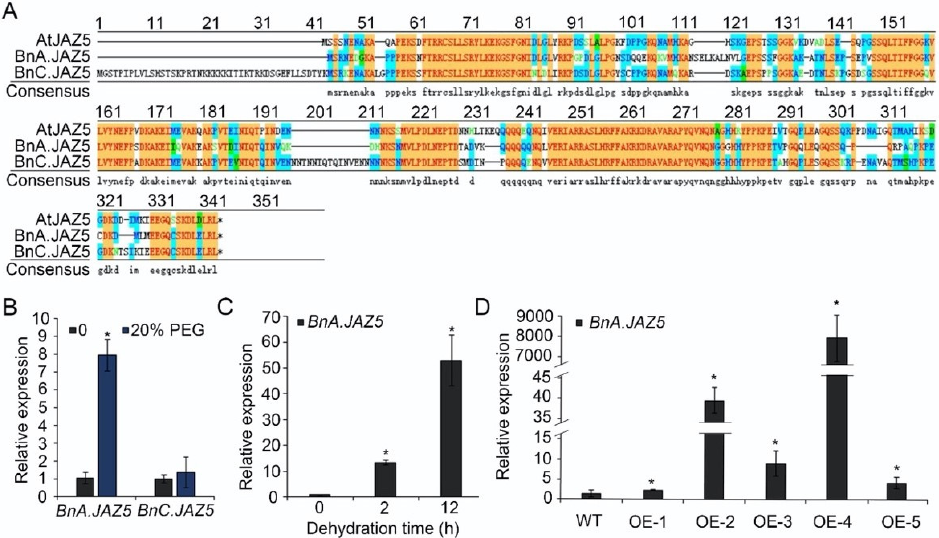
Figure 1. Homologous alignment of AtJAZ5 in rapeseed and expression levels of BnA.JAZ5 and BnC.JAZ5 . ( A ) Alignment of the protein sequences of AtJAZ5 in Arabidopsis and BnA.JAZ5 and BnC.JAZ5 in B. napus . ( B ) Expression levels of BnA.JAZ5 and BnC.JAZ5 under 20% PEG-6000. ( C ) Expression levels of BnA.JAZ5 under dehydration stress. Detached leaves of five-leaf-stage plants were subjected to dehydration treatment for 2 and 12 h. ( D ) The expression levels of BnA.JAZ5